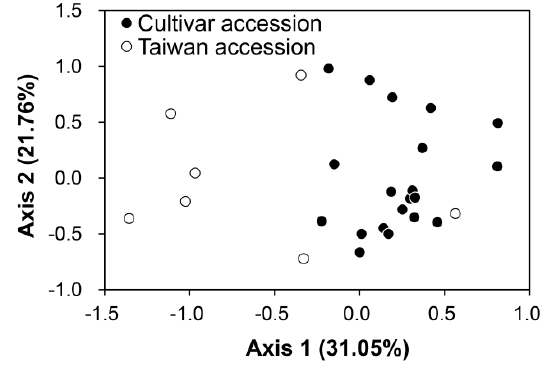
Figure 3. Population structure estimated by the principle coordinate analysis (PCoA). Scatter plot of the first axis (31.05% explanation) and the second axis (21.76% explanation) of the PCoA based on variations of 8 microsatellite loci (excluding the F CMBR31 and CMBR114-1). The black and white dots indicated the individuals from “the cultivar accession” and “the Taiwan accession”,